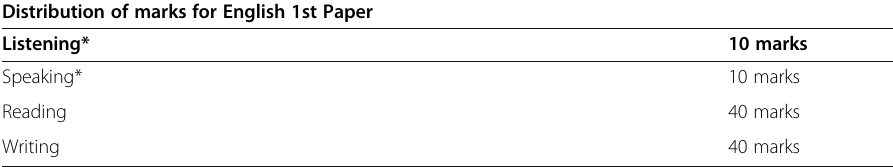
Table 3 Distribution of marks for English 1st Paper (NCTB, 2012) Distribution of marks for English 1st